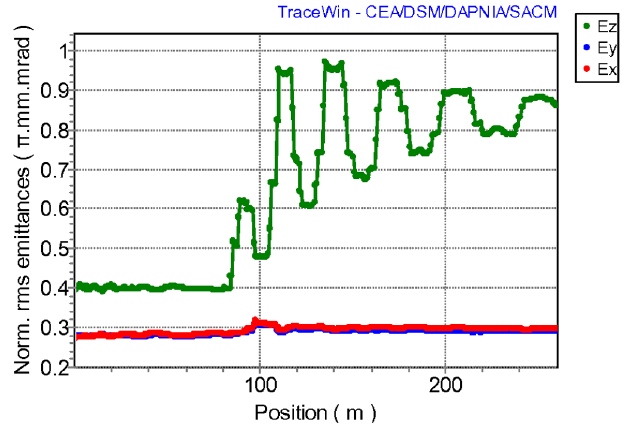
FIG. 17. (Color) Emittances along the linac at 140 (cid:4) s FIG. 18. (Color) Field in cavity #1.